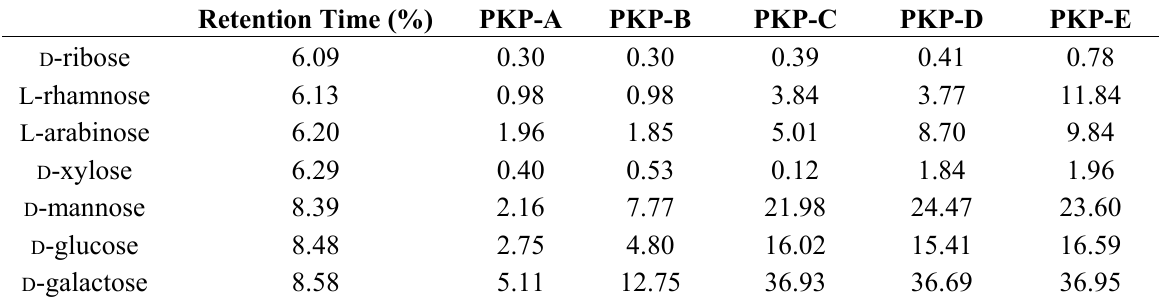
Table 3. Molar proportions of seven monosaccharides of